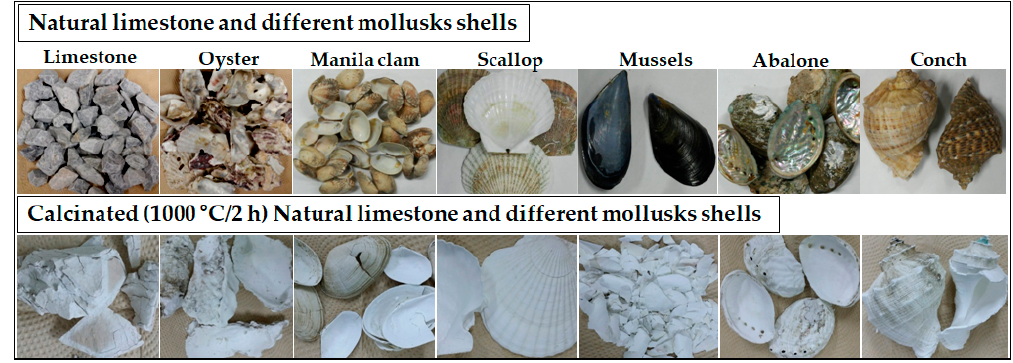
Figure 3. Raw mollusk shells with limestone and calcinated mollusk shells with calcinated limestone at 1000 ° C/ 2 h.